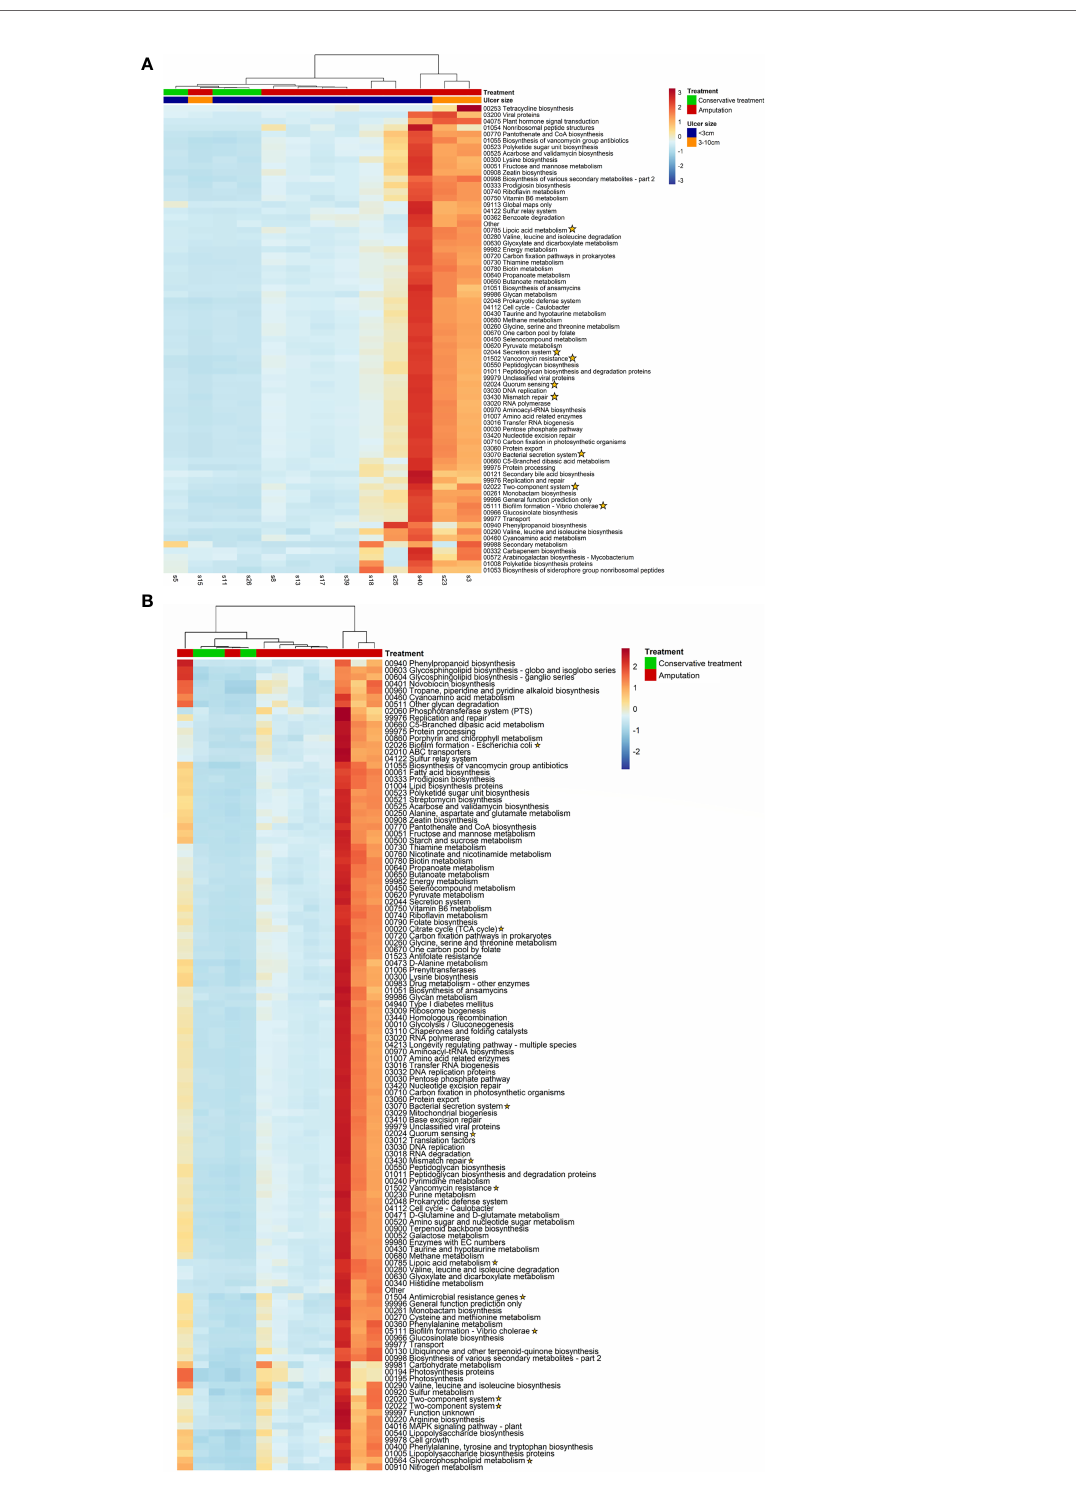
FIGURE 6 | (A, B) . Analysis of functional genes. Yellow stars indicate genes related to bacterial virulence factors. (A) A cluster of fi ve samples of patients with IDFU who underwent amputation. These patients had more severe peripheral vascular disease compared to other patients, p=0.003. (B) Functional genes differentiating patients who underwent amputation from patients who were treated